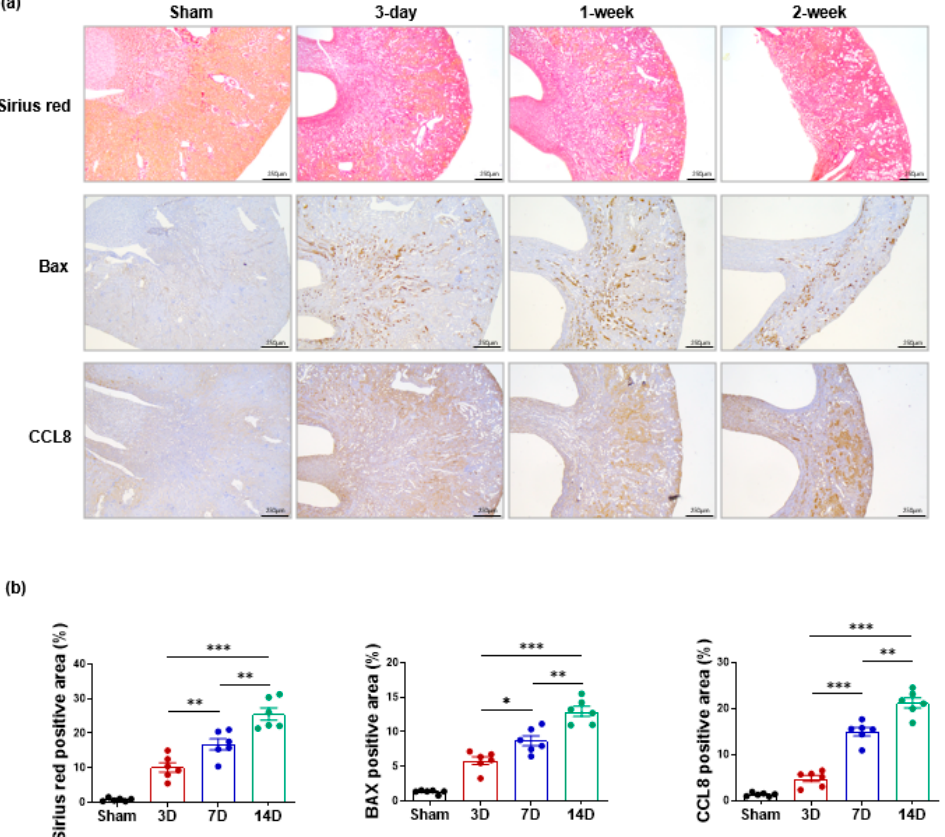
Figure 6. The immunohistochemical analysis showed that the expression of type I collagen, Bax, a marker of apoptosis, and CCL8 was strongly induced 1 week after the unilateral ureteral obstruction (UUO) and became more pronounced 2 weeks after the UUO (original magnifications, Panel ( a ), ×40). Quantification was performed by computer-based morphometric analysis. The three indicated marker-positive area was increased significantly over time ( b ). * p < 0.05, ** p < 0.01, and *** p < 0.001.